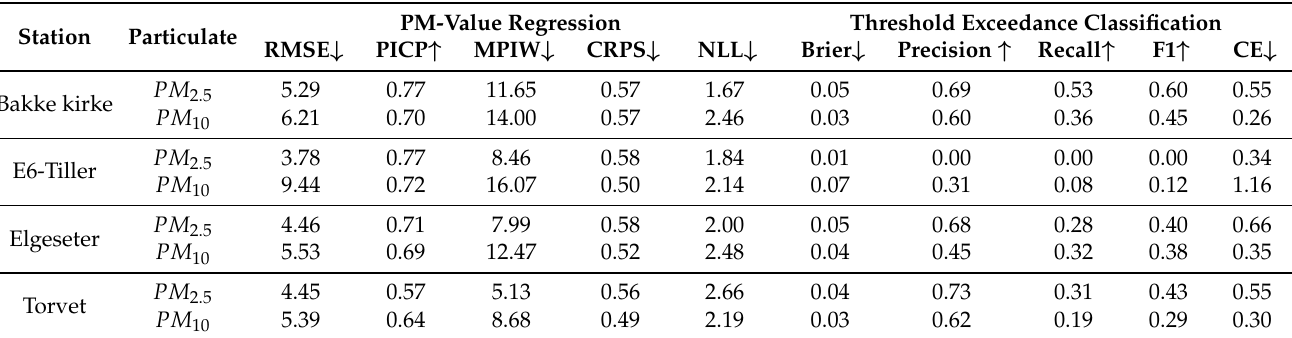
Figure 16. Predicting threshold exceedance probability of air pollutants level using a deep ensemble. Table 4. Summary of performance results when forecasting the PM-value and threshold exceedance using a deep